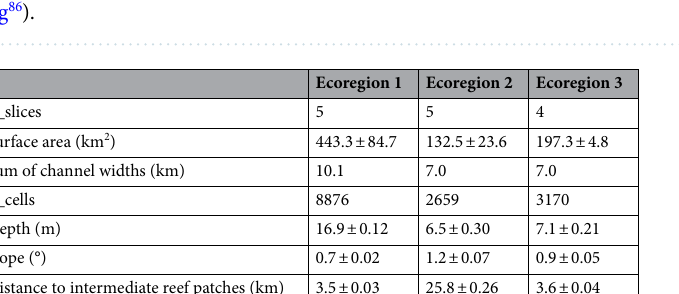
Figure 1. Interpolated dugong GPS tracks recorded in 2012, 2013 and 2019 over the west coast of New Caledonia, South Pacific. The 16 tracks are split in different colors depending on the ecoregion they are in. Ecoregions identified through hierarchical clustering of environmental lagoon characteristics are represented with colored polygons. Ecoregion 3 is divided into two separate parts, one to the north of ecoregion 2 and another in between ecoregion 1 and 2. Land is shown in black and shallow reefs are shown in grey (shapefile source: Millenium Coral Reef Mapping Project 69,70 ). The map was created with R (version 3.6.3, www.r- proje ct. org 86 ).